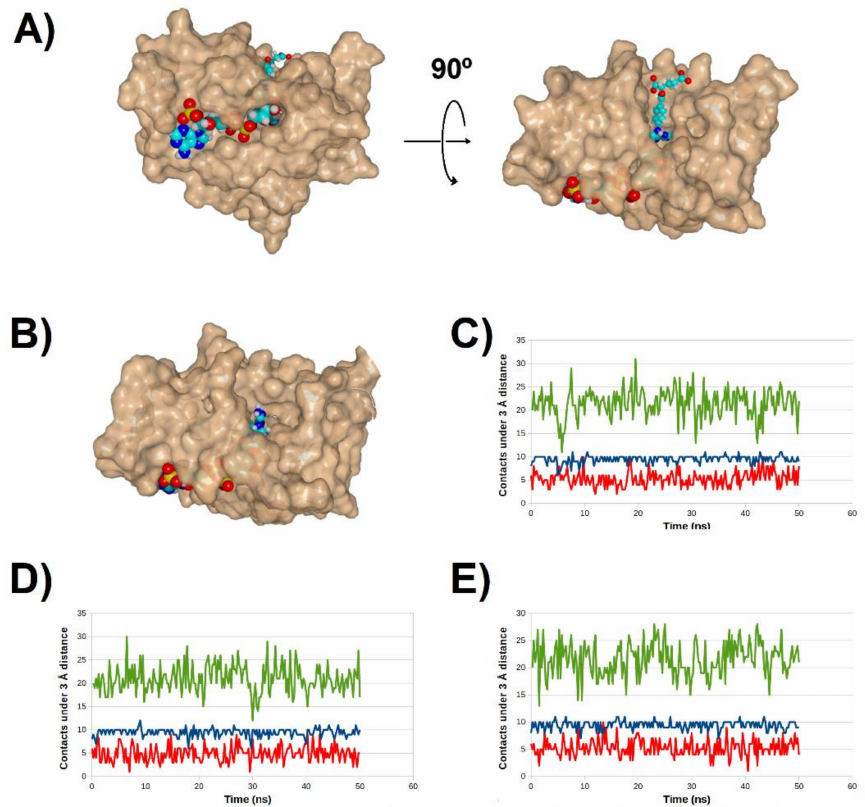
Figure 9. Comparing binding modes of chromosomally encoded prokaryotic dihydrofolate reductase towards dihydrofolate and molecule 32 . ( A ) Active site architecture of dihydrofolate-bound DHFR from S. aureus (PDB:3FRD); ( B ) final binding mode (after 50 ns) of molecule 32 . Protein orientation is the same as in the right-most panel of Figure 8A; ( C – E ): evolution of number of contacts between molecule 32 and NADPH/protein in three replicate simulations: green: number of protein atoms within 3 Å of ligand; red: number of NADPH atoms within 3 Å of ligand; blue: number of residues within 3 Å of